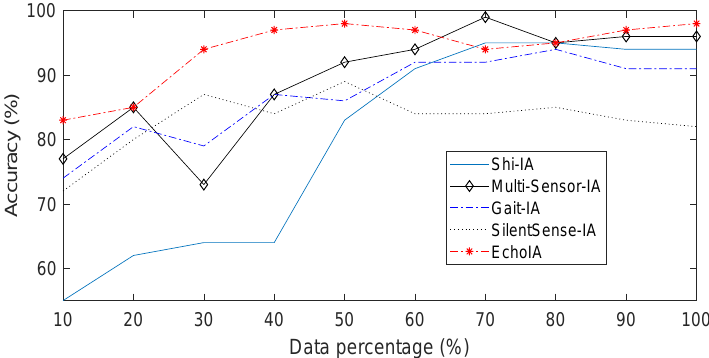
Figure 3. Accuracies for different IA schemes.